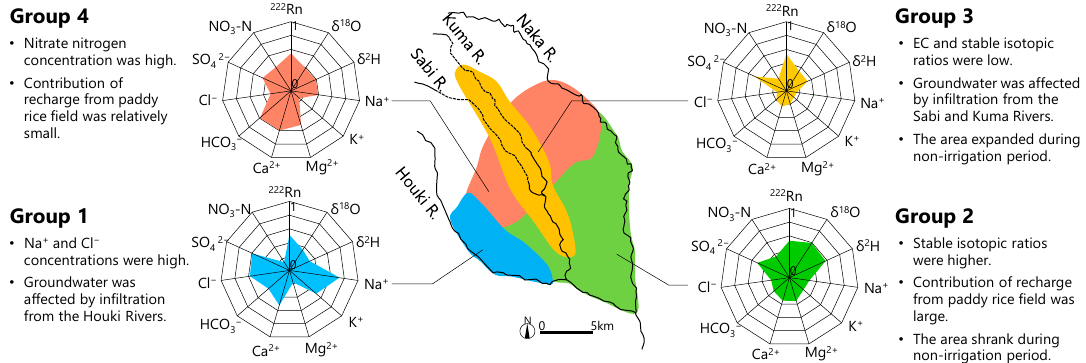
Figure 15. Characteristics of the Nasunogahara alluvial fan groundwaters in each of the four groups. Medians of all variables plotted on the radar charts were transformed to range from 0 to 1.